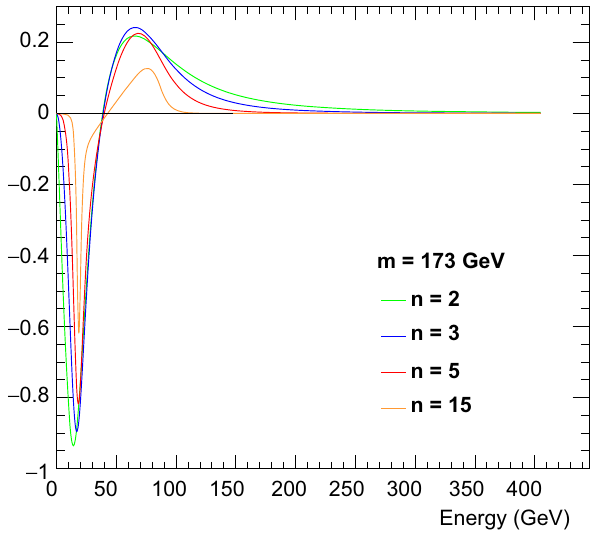
Fig. 3 Weight functions W ( E (cid:2) , m ) provided by the authors of Ref. [8] corresponding to n = 2, 3, 5, 15 in Eq. (2) with m = 173 GeV